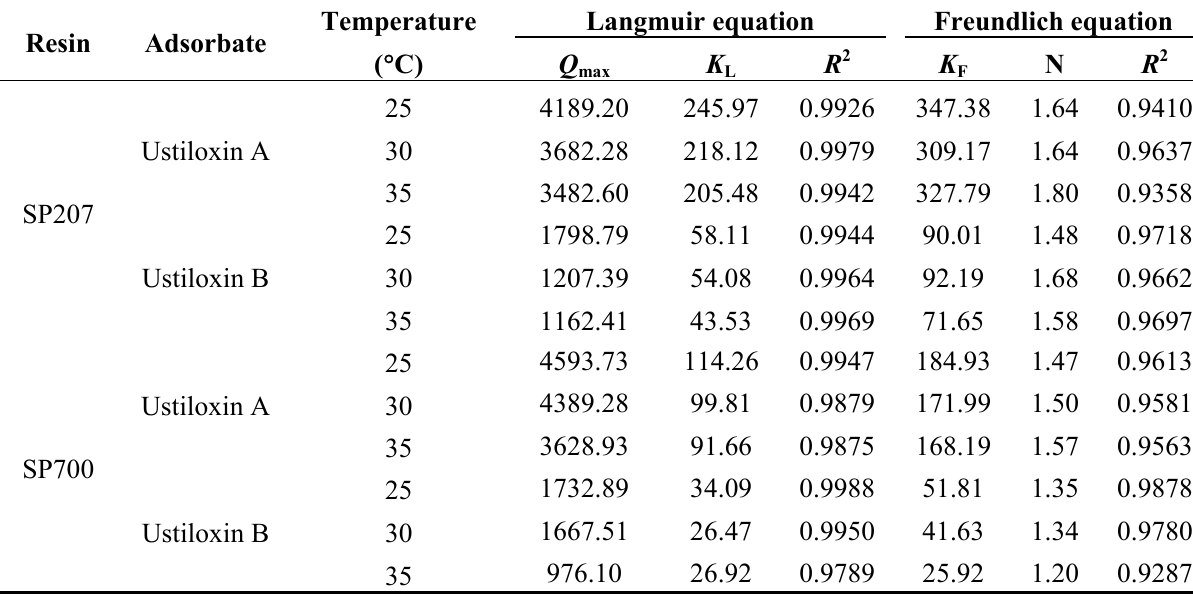
Table 2. Langmuir and Freundlich parameters of ustiloxins A and B on resins SP207 and SP700. Resin